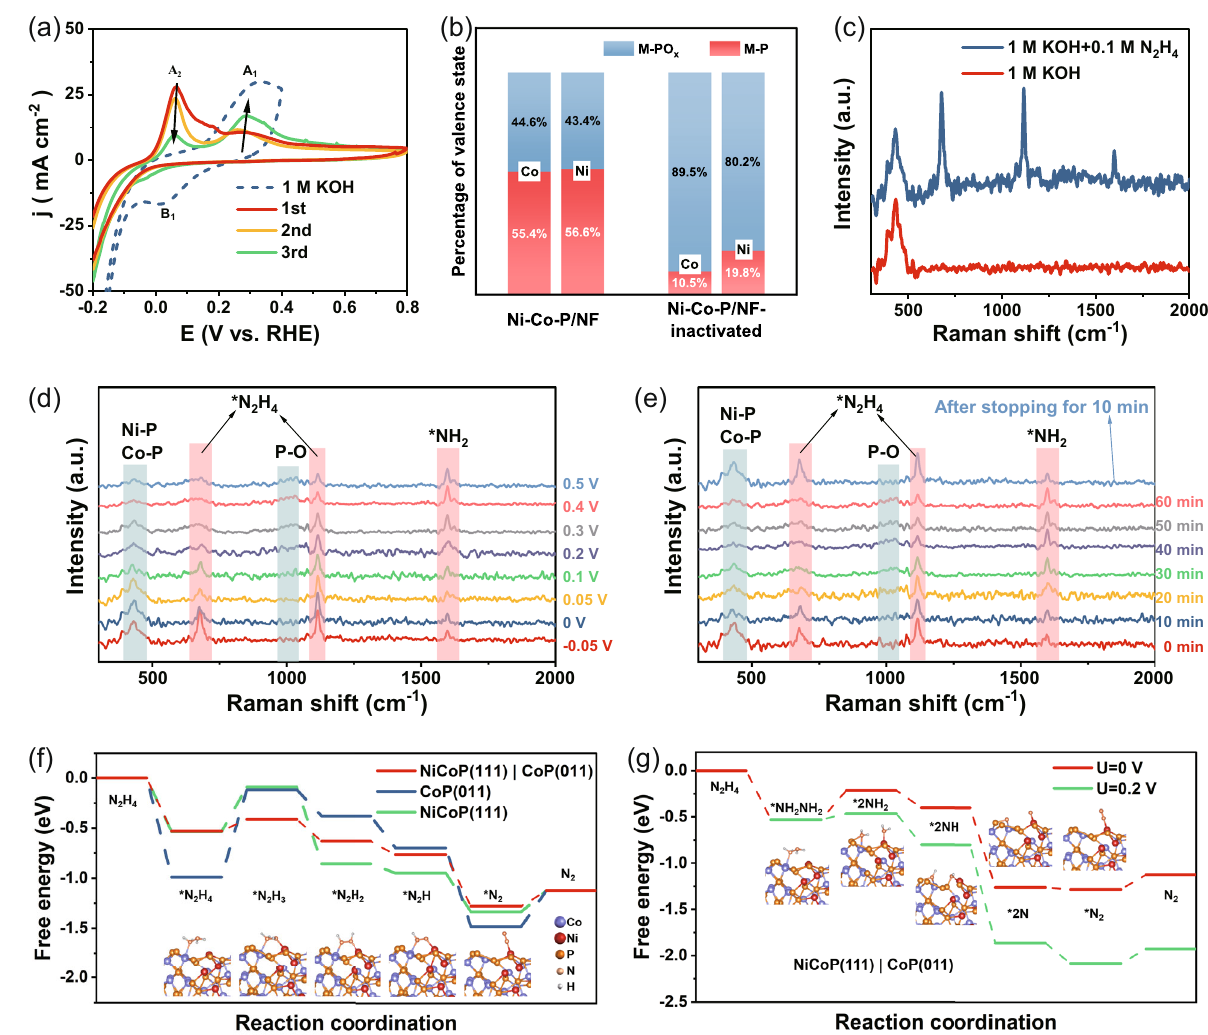
Fig. 5 | Catalytic mechanism of HzOR and the catalyst ’ s evolution during cat- alysis. a CV curves in 1M KOH (blue curves) or 1.0M KOH+0.005M N 2 H 4 under different cycles of scanning (red: fi rst cycle, yellow: second cycle and green: third cycle); b Histograms of the ratiobetween MPO x and MP for the surface of Ni-Co-P/ NF and Ni-Co-P/NF-inactivated; c Raman spectra of Ni-Co-P/NF in 1M KOH or 1M KOH+0.1MN 2 H 4 ;( d , e